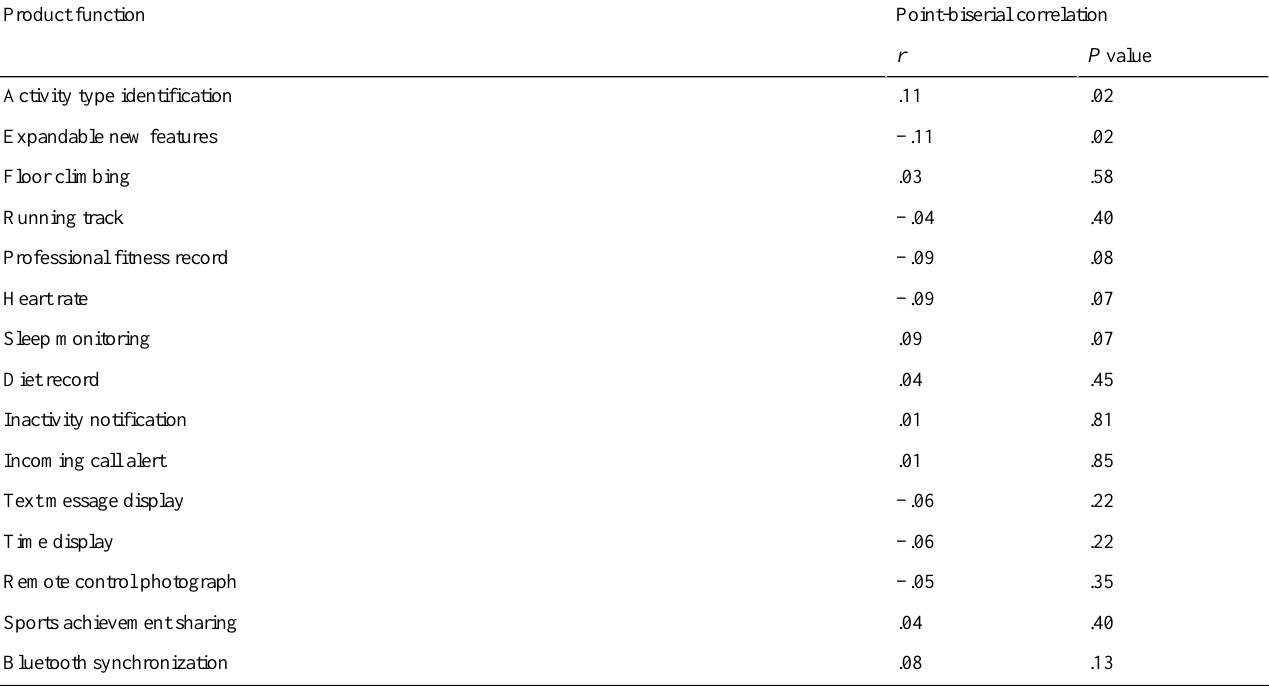
Table 6. Point-biserial correlation analysis between the System Usability Scale (SUS) scores and product functions (N=388).